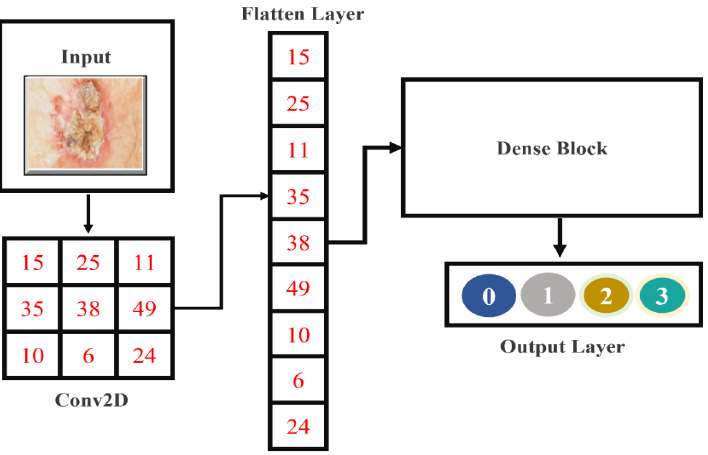
Figure 5. The fundamental structure of the flattened